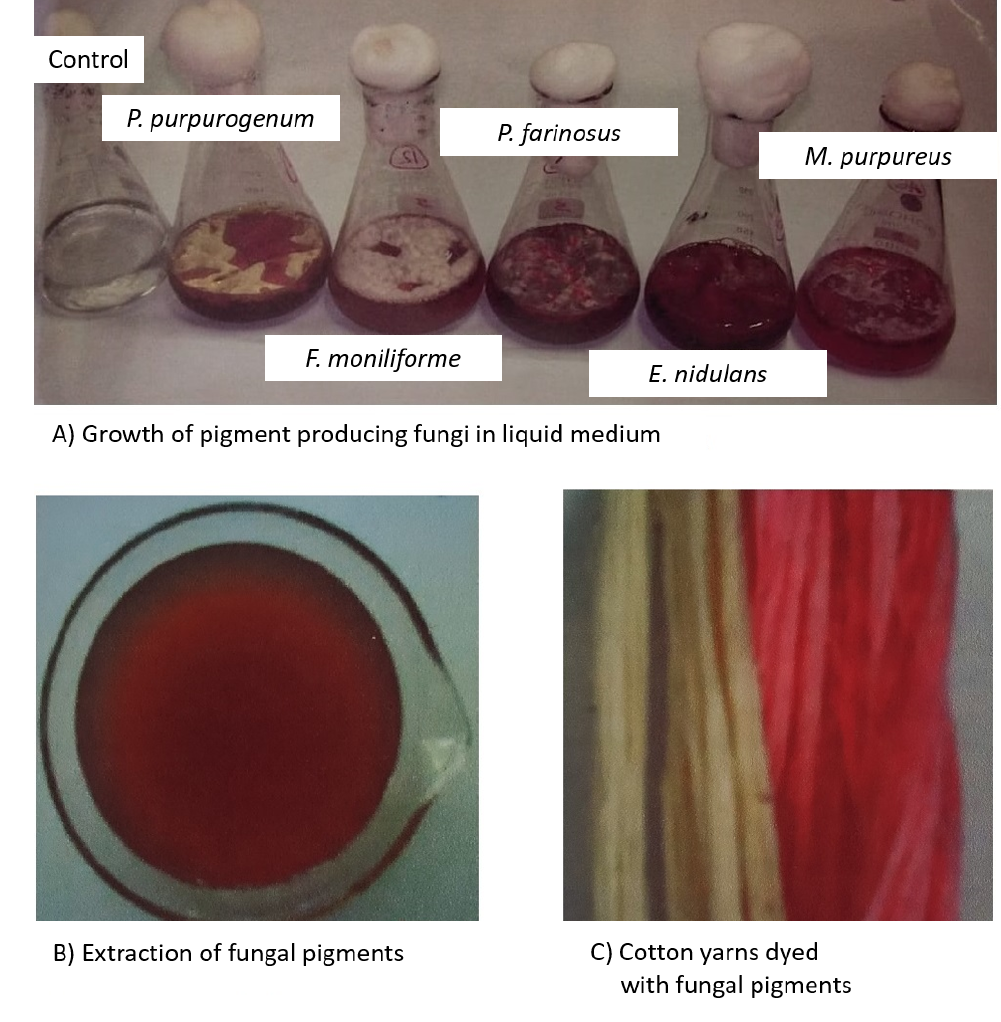
Figure 2. Water-soluble fungal pigments for dyeing cotton yarns. A) Growth of pigment producing fungi in liquid medium; B) Extraction of fungal pigments; C) Cotton yarns dyed with fungal